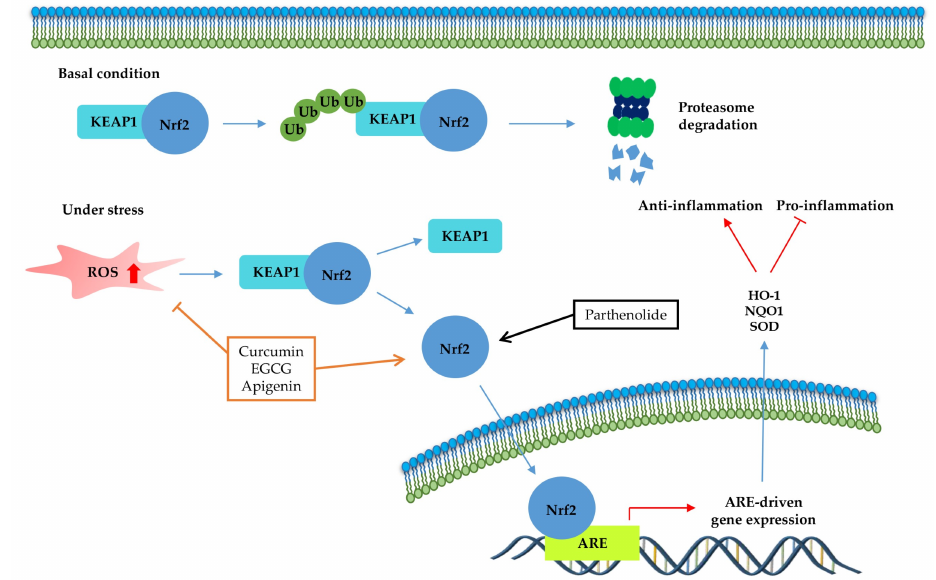
Figure 4. Kelch-like ECH-associated protein 1 (Nrf2-Keap1)-antioxidant response element